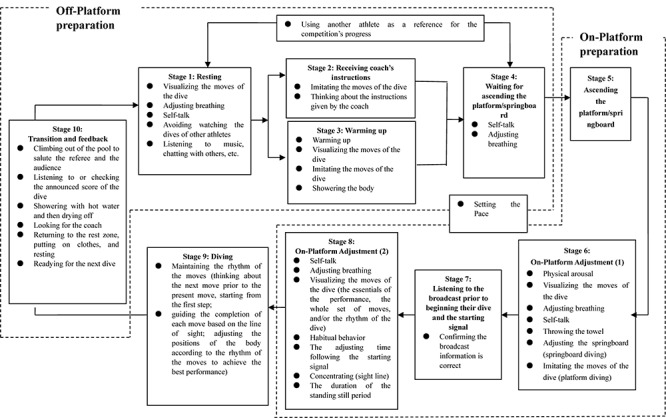
The diving PPRs.